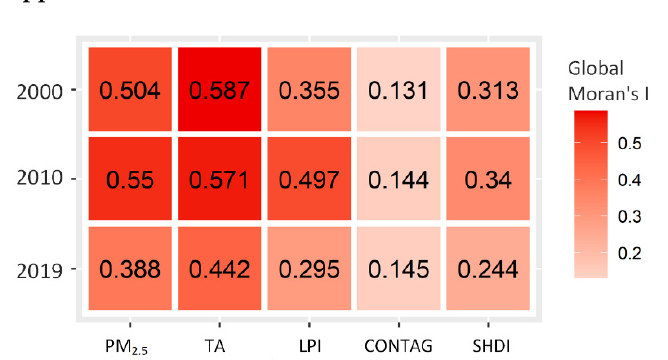
Figure A1. Global Moran’s I of PM 2.5 and green space landscape indexes (all of the Moran’s I values are significant at the level of 1%). Table A1. Examples of PM 2.5 concentration guidelines.